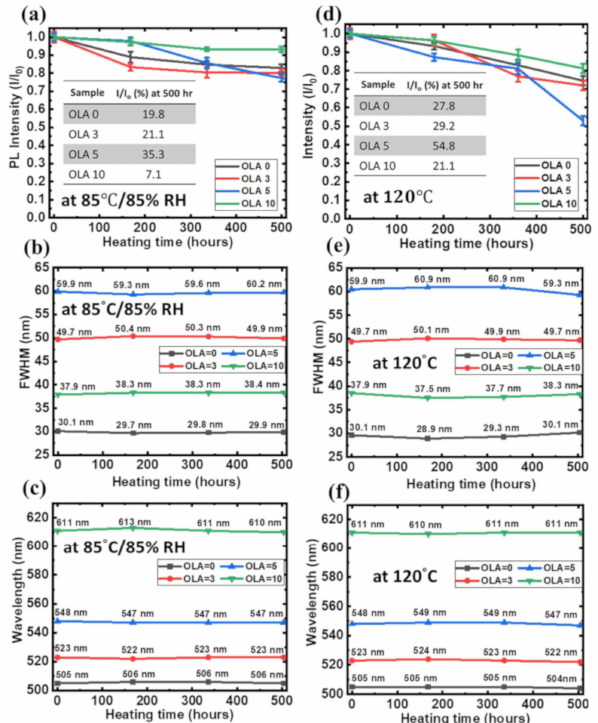
Figure 10. Thermal stability tests of QDs on glass at 85 ◦ C/85% RH and 120 ◦ C ( a , d ); traces of PLI, ( b , e ) FWHM, and ( c , f ) wavelength during 500